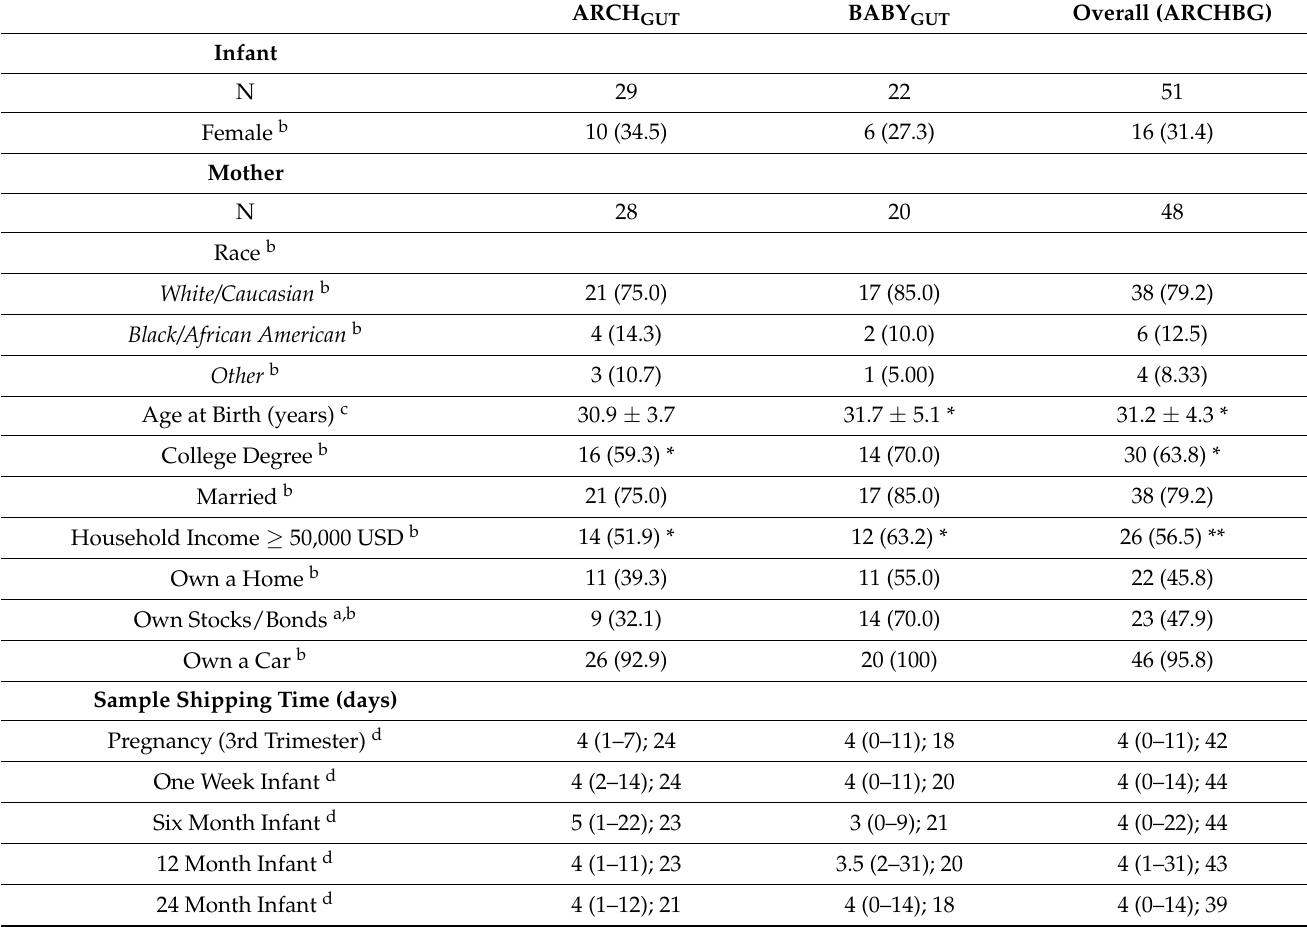
Table 3. Sociodemographic information and sample shipping time for ARCHBG